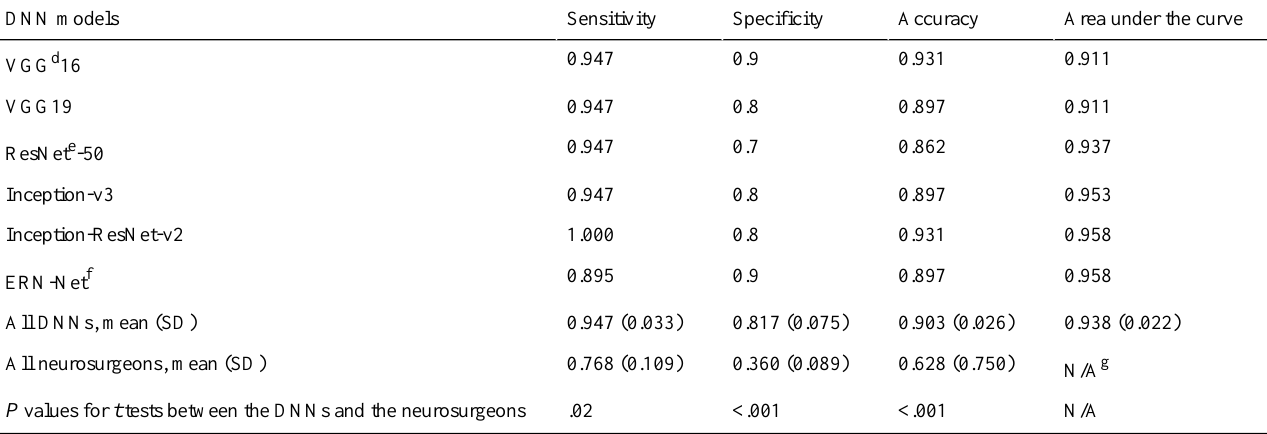
Table 5. Performance of different deep neural network (DNN) models for subject-based classification; the T1 a -T2 b -T1c c -fused images were used as the input to the models.